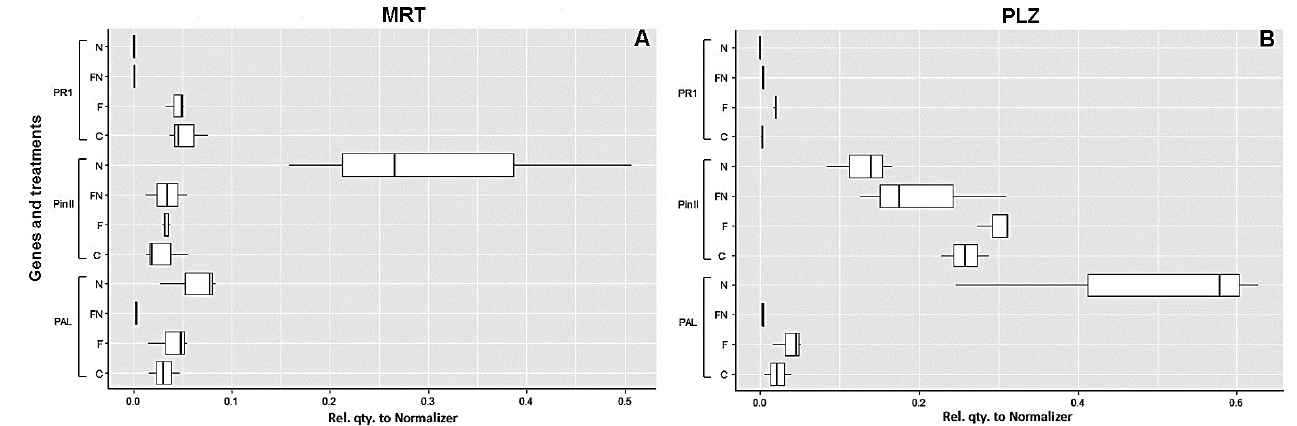
Figure 3. Expression of defense response genes PR1 , Pin II and PAL 5 by treatments in tomato cv Regina di Fasano accessions MRT ( A ) and PLZ ( B ) (see Table 2 for description of treatments). Gene expression levels are shown along the x-axes as relative quantities of transcripts compared to the actin normalizer.